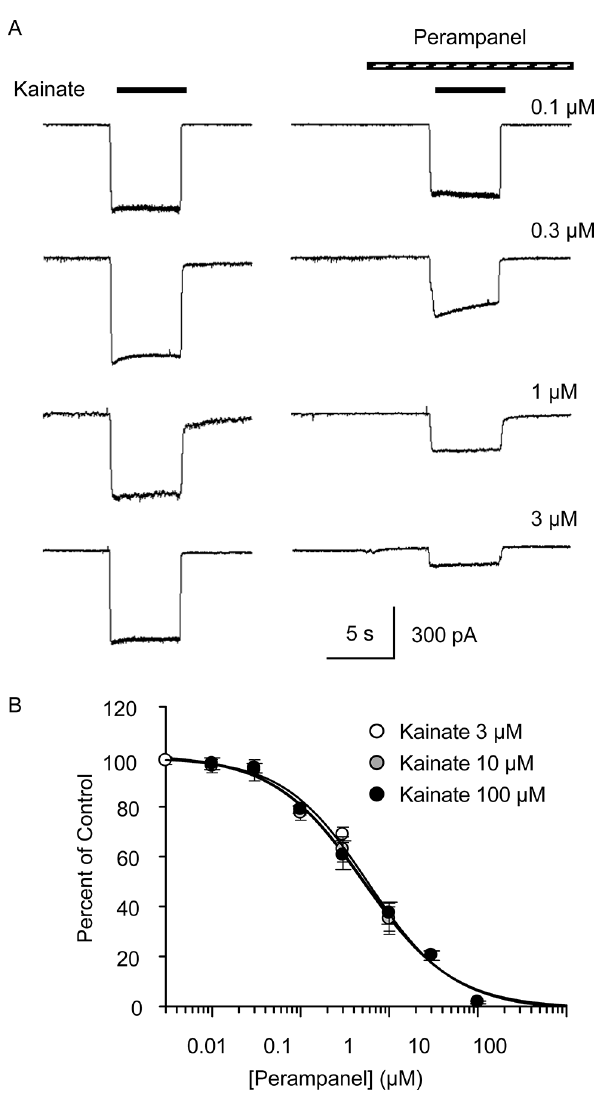
Figure 2. Perampanel inhibition of kainate-evoked currents in cultured hippocampal neurons. (A) Sample currents evoked by 100 m M kainate in 4 neurons in the absence ( left panels ) and presence ( right panels ) of perampanel at the concentrations indicated. The percent inhibition values (derived from the current amplitude in the absence of perampanel and the corresponding current amplitude in the presence of perampanel) are 20%, 41%, 55%, and 80% at concentra- tions of 0.1, 0.3, 1, and 3 m M, respectively. (B) Current amplitude values evoked by various kainate concentrations expressed as percent of control prior to perampanel. Curves represent logistic fits to the data for each kainate concentration. Data points represent mean 6 S.E.M. of values from 3 to 6